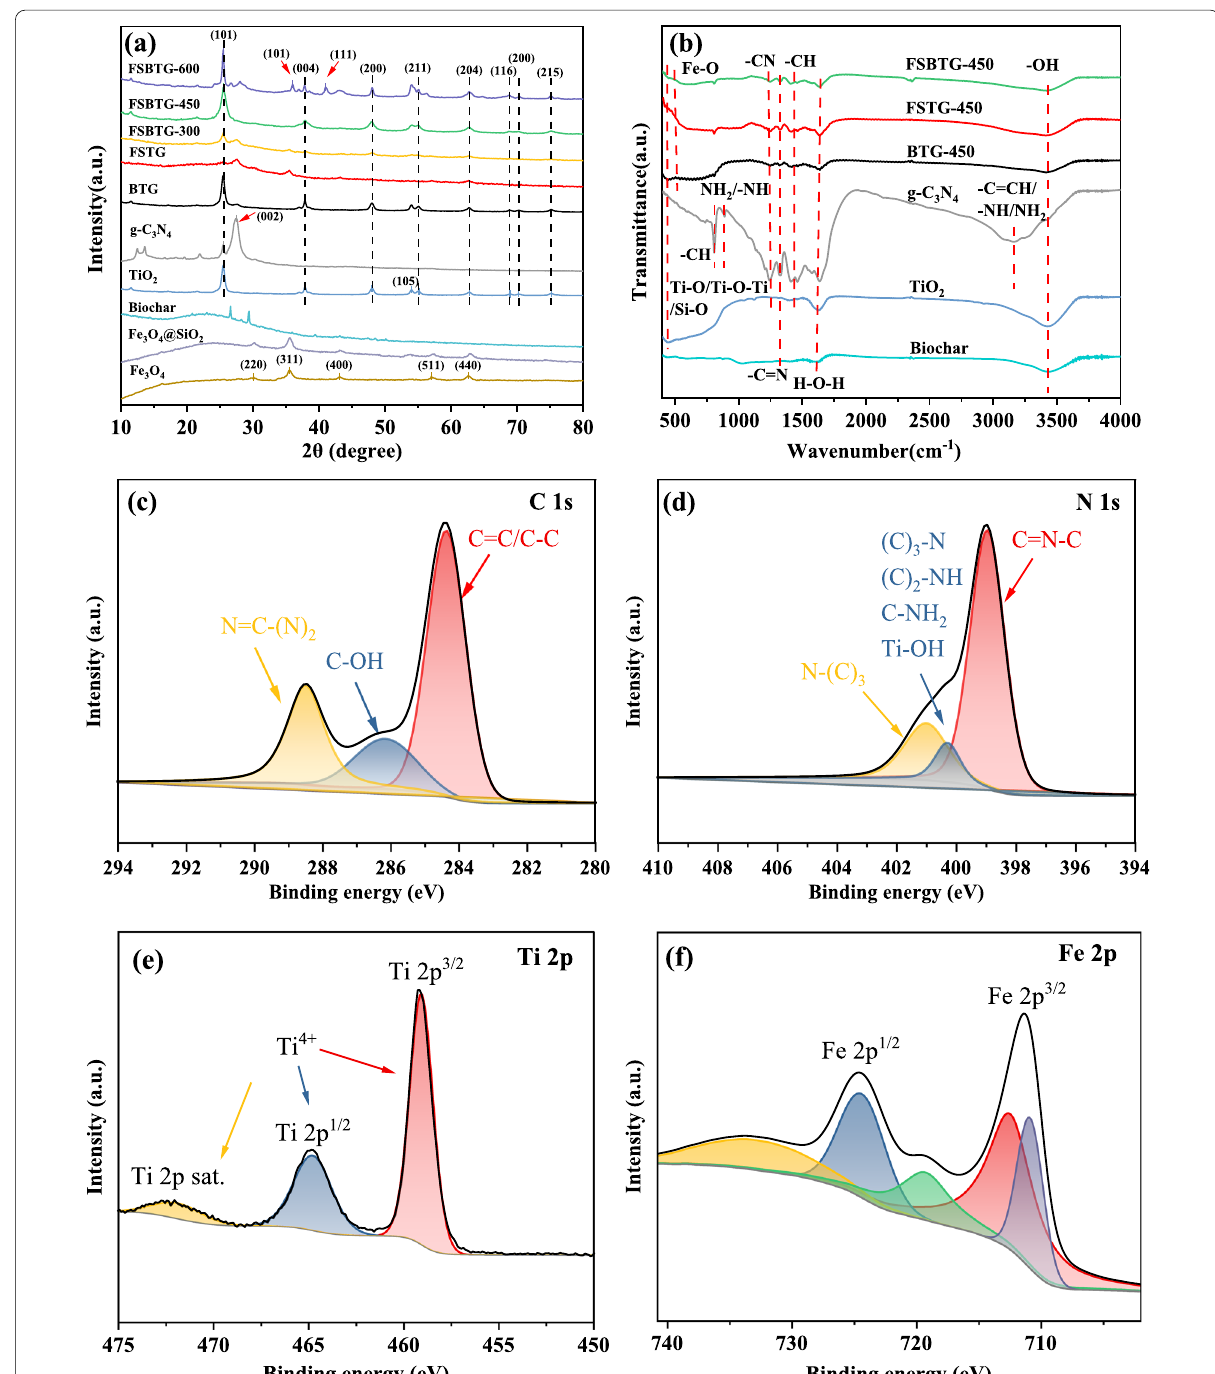
Fig. 2 XRD patterns ( a ); FT-IR spectra ( b ) of TiO 2 , g-C 3 N 4 and several g-C 3 N 4 -based photocatalysts; high-resolution XPS spectra of C 1 s ( c ), N 1 s ( d ), Ti 2p ( e ), and Fe 2p ( f ) of